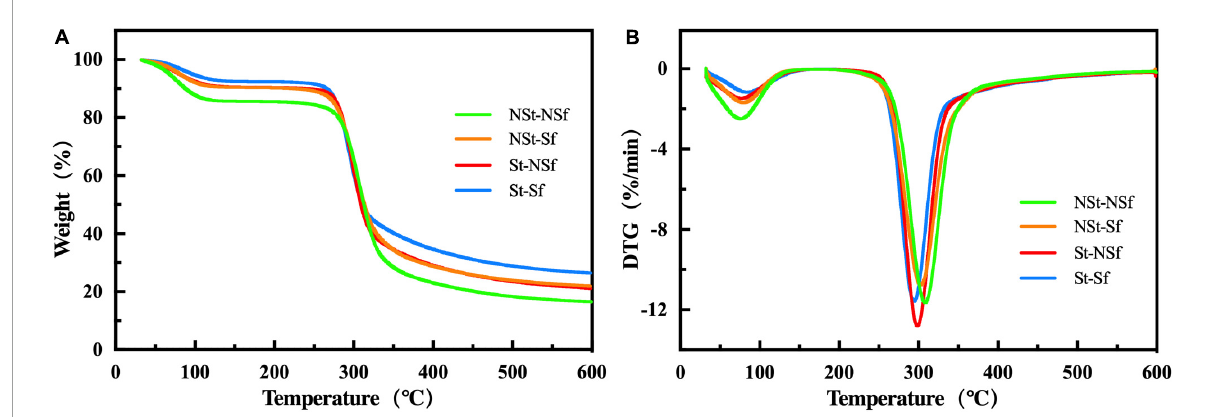
FIGURE7 Thermogravimetric curves of weight changes with temperature (A) and derivative thermogravimetry (DTG) changes with temperature (B) of Gastrodia elata starch treated with nonsteam (NSt), steam (St) and nonsulfur fumigation (NSf), sulfur fumigation